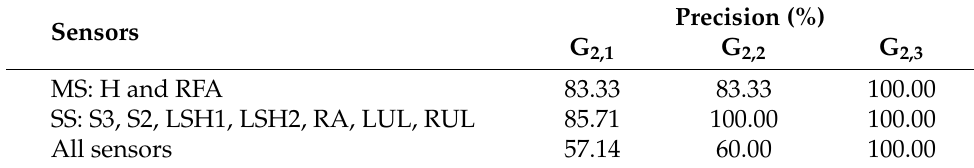
Table 9. Precision achieved for G 2 using HMMs.